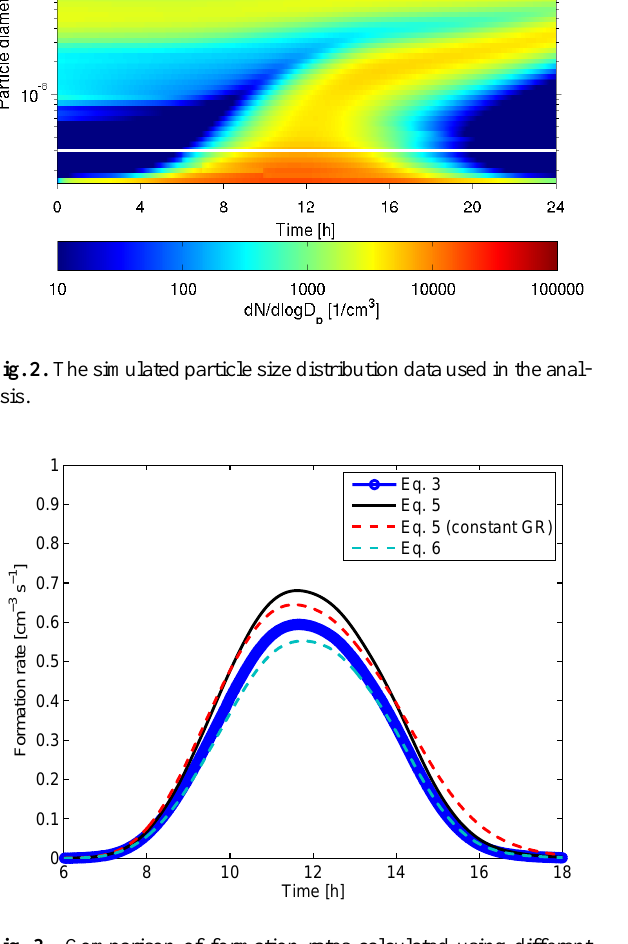
Fig. 3. Comparison of formation rates calculated using different methods during a simulated new particle formation event.